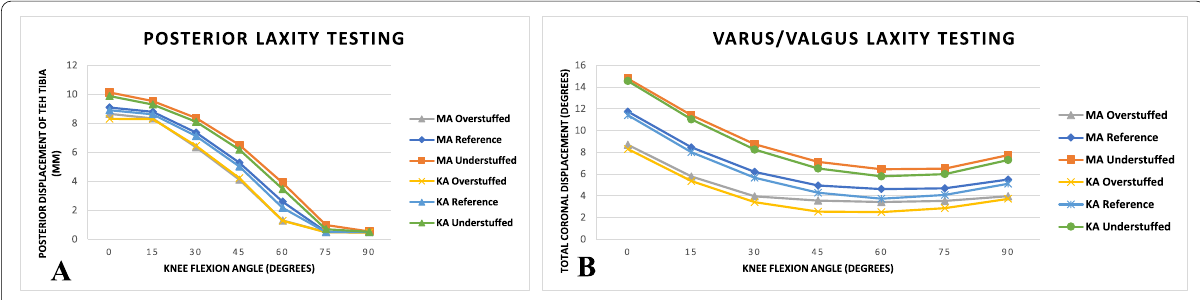
Fig. 4 Graphs illustrating the joint laxity test results. A Posterior, B Varus/valgus